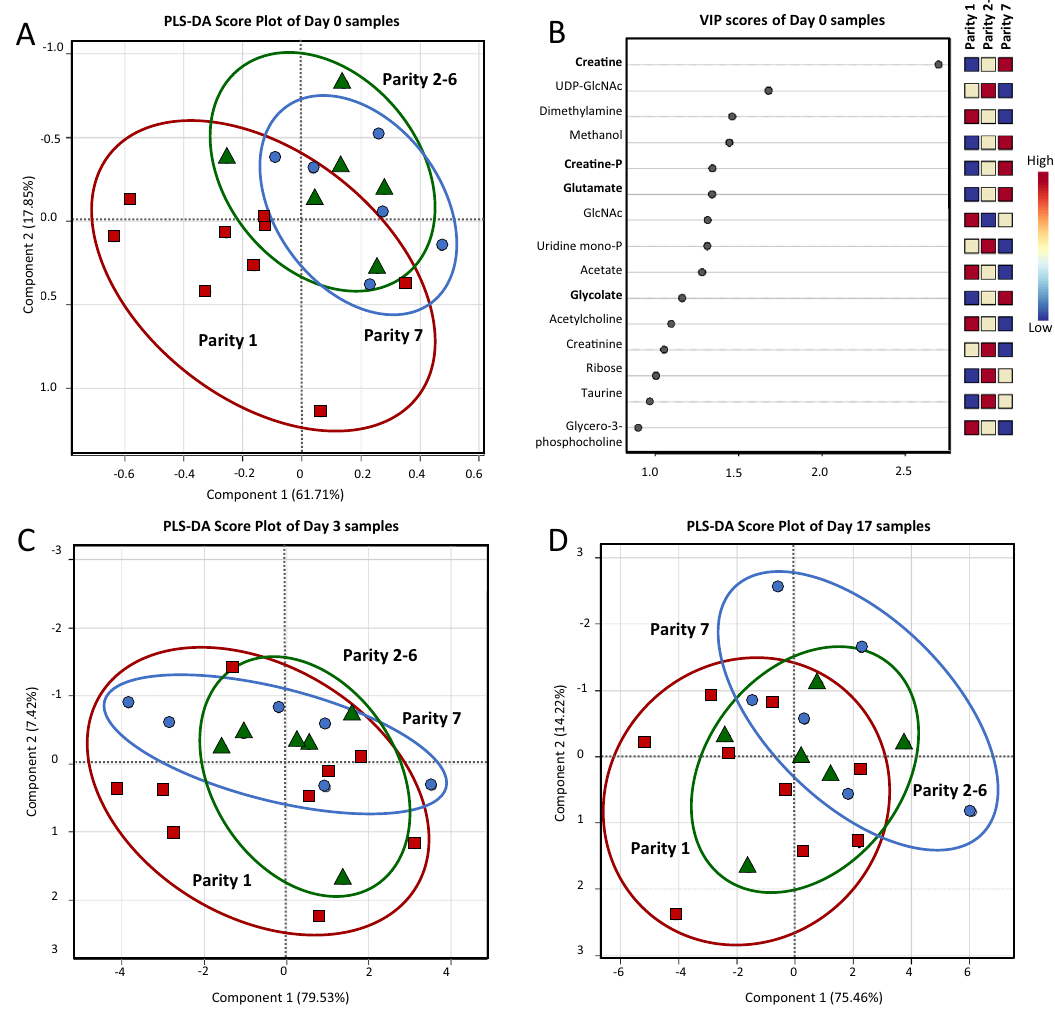
Figure 4. PLS-DA score plots for the comparison of non-volatile polar metabolite profiles of colostrum (day 0; panel A ), transient milk (day 3; panel C ) and mature milk (day 17; panel D ) samples collected from sows in parity 1 ( (cid:31) ), parity 2–6 ( (cid:31) ) and parity 7 ( (cid:31) ). VIP scores derived from the comparison among colostrum samples (day 0) with indicative metabolites accountable for the discrimination and their relative abundances are visualized in panel B